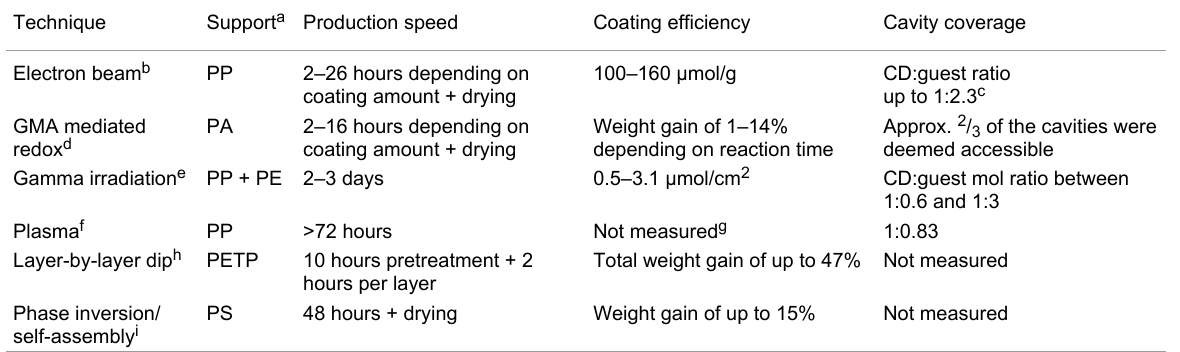
Table 1: Examples from the literature of the use of immobilised CDs for water purification.